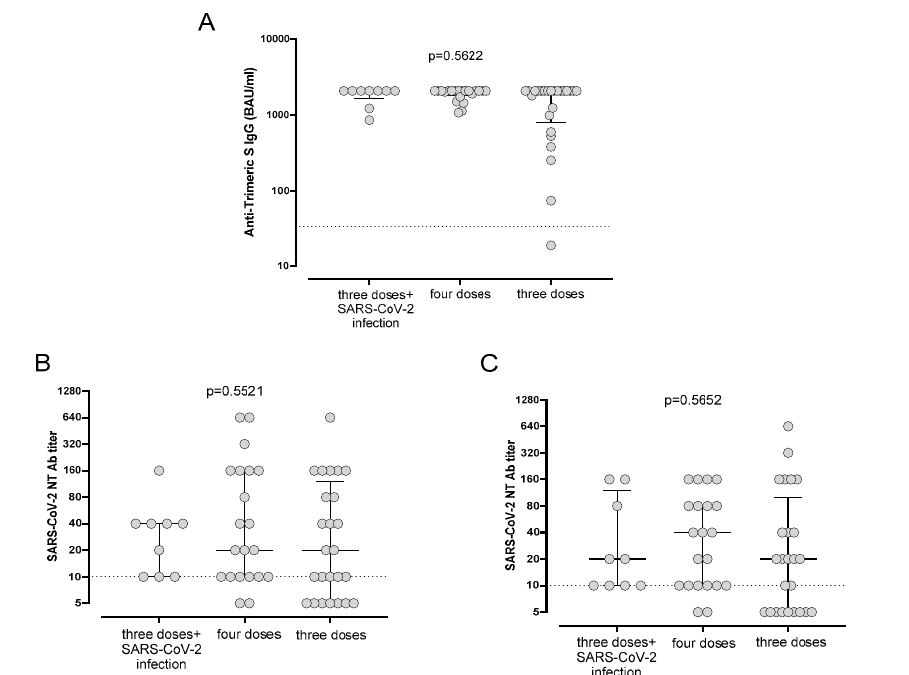
Figure 3. Levels ( A ) of anti-trimeric S IgG and SARS-CoV-2 NT Abs against ( B ) Omicron 1 (BA.1) and ( C ) Omicron 5 (BA.5) variants in patients who had and had not experienced infections at T3. IgG, immunoglobulin G; NT Ab, neutralizing antibody.